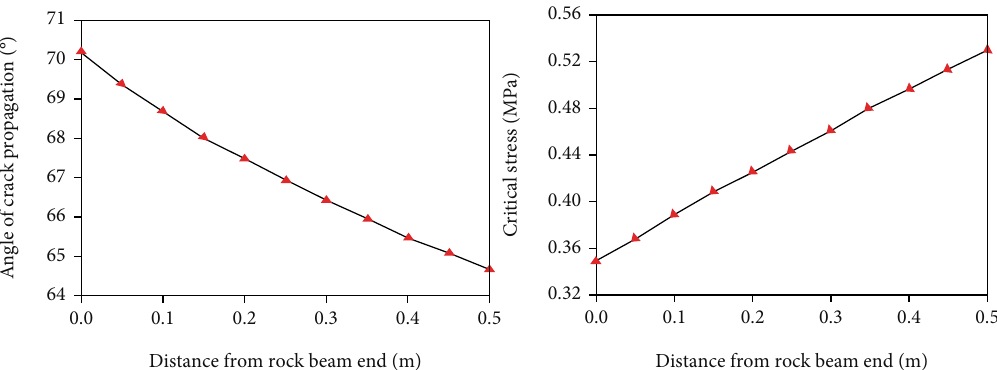
Figure 12: Analysis of crack propagation angle and critical stress and sensitivity of distance beam end.